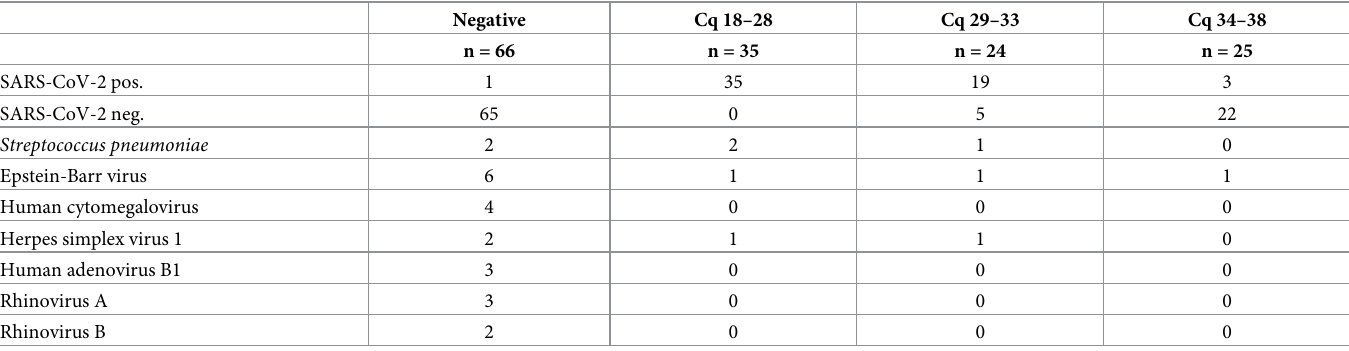
Table 3. Results of the RespiCoV analyses for 150 samples from patients with suspected SARS-CoV-2 infection (negative = 66, positive = 84). Sequences of 32 patho- gens other than SARS-CoV-2 could be identified, with 23 pathogens in 17 of the 66 negative samples. Co-infections were identified in 8 of the SARS-CoV-2-positive samples.